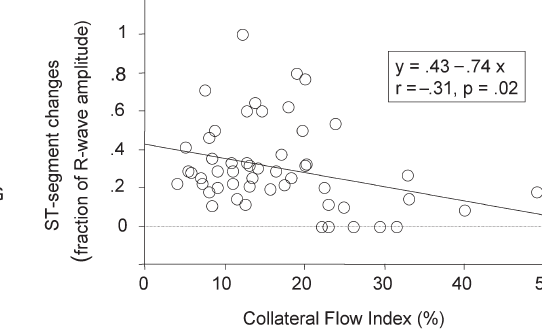
Correlation between ST-segment changes (vertical axis) and collateral flow index (horizontal axis) at the end of occlusion. There is a significant inverse linear relationship be- tween signs of ischaemia and collateral supply during vessel occlusion with and without cold pressor test. Abbreviations: CFI = collateral flow